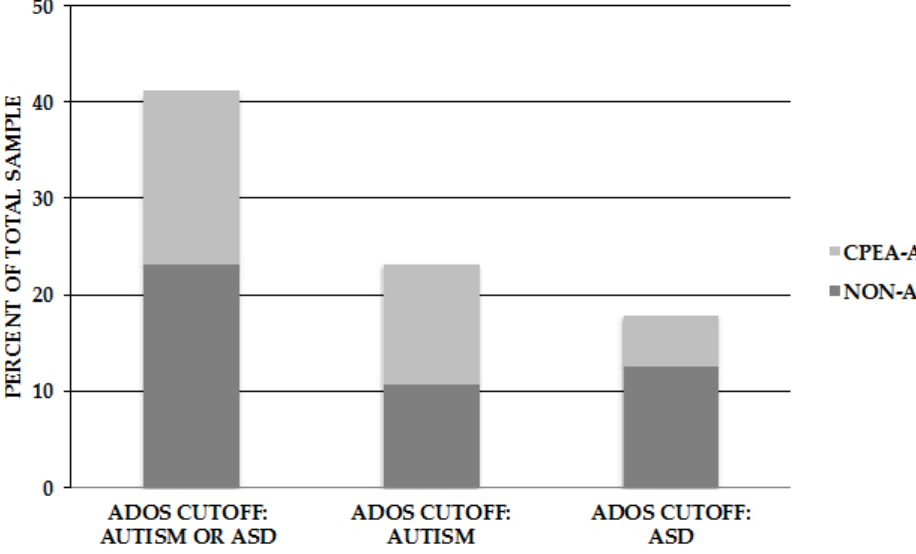
Figure 2. Figure 2 shows the broad range of ADI-R Restricted, Repetitive, and Stereotyped Behavior algorithm total scores (0–12; the ASD cutoff score ≥ 3 is indicated by the black vertical line). The x -axis shows the algorithm score, and the y -axis indicates the number of individuals with each score.